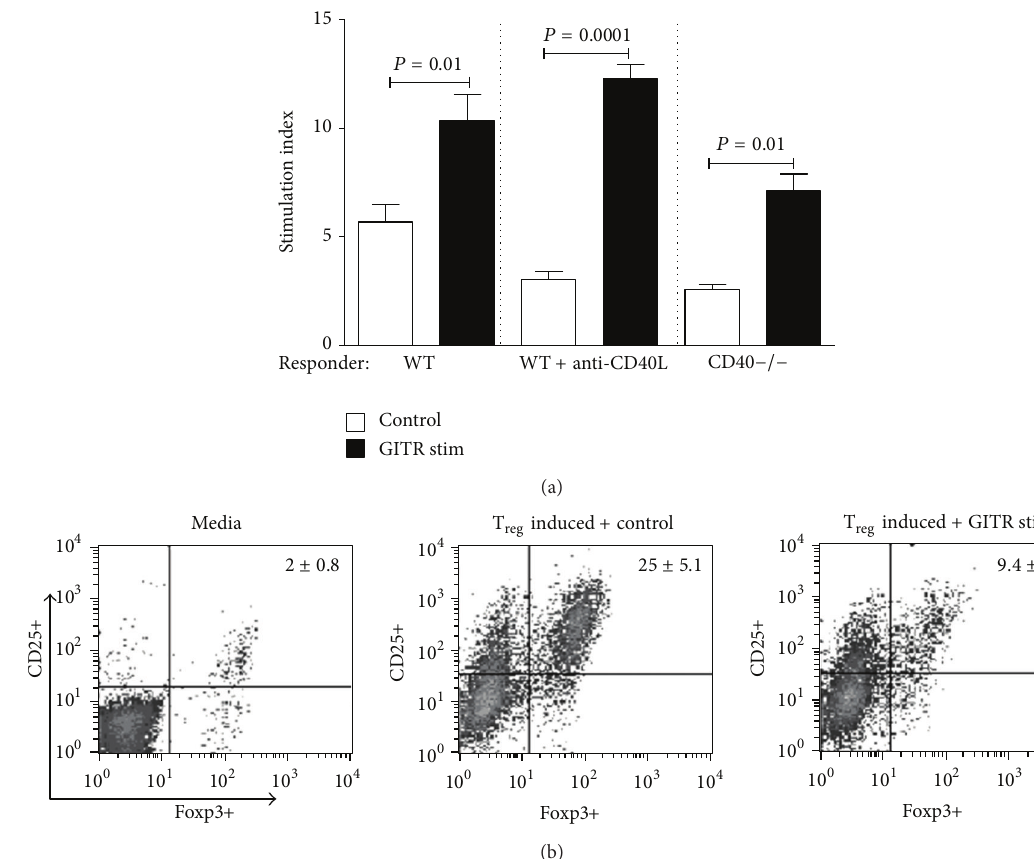
Figure 2: GITR stimulation increases graft-reactive T cell proliferation and inhibits T development. (a) WT C57BL/6 splenocytes eff reg were cultured in the presence of irradiated WT BALB/c splenocytes (WT) or with irradiated WT BALB/c splenocytes + 100 𝜇 g/mL anti- CD40L mAb (WT+anti-CD40L); CD40 − / − C57BL/6 splenocytes were cultured with irradiated CD40 − / − BALB/c splenocytes. Cultures were maintained in the presence of 100 𝜇 g/mL of anti-GITR mAb (black bars) or control IgG (open bars) for 5 days and were assayed for proliferation by [ 3 H] thymidine incorporation. Stimulation index was defined as responder + stimulator cpm/responder alone cpm. Average values generated from 3 independent experiments are depicted, and significance was determined via paired Student’s t -test. (b) Na¨ıve splenocytes were isolated from Foxp3-GFP knock-in mice and were cultured for 72 hours in media (left panel), in media containing inducing media) + 100 𝜇 g/mL IgG isotype control 10U/mL recombinant IL-2, 10ng/mL recombinant TGF- 𝛽 , and 2% anti-CD3 mAb (T reg inducing media + 100 𝜇 g/mL anti-GITR mAb (right panel). Examples of CD25+ versus Foxp3 GFP+ cell staining (middle panel), or in T reg from 3 independent experiments are pictured along with the average % staining ±